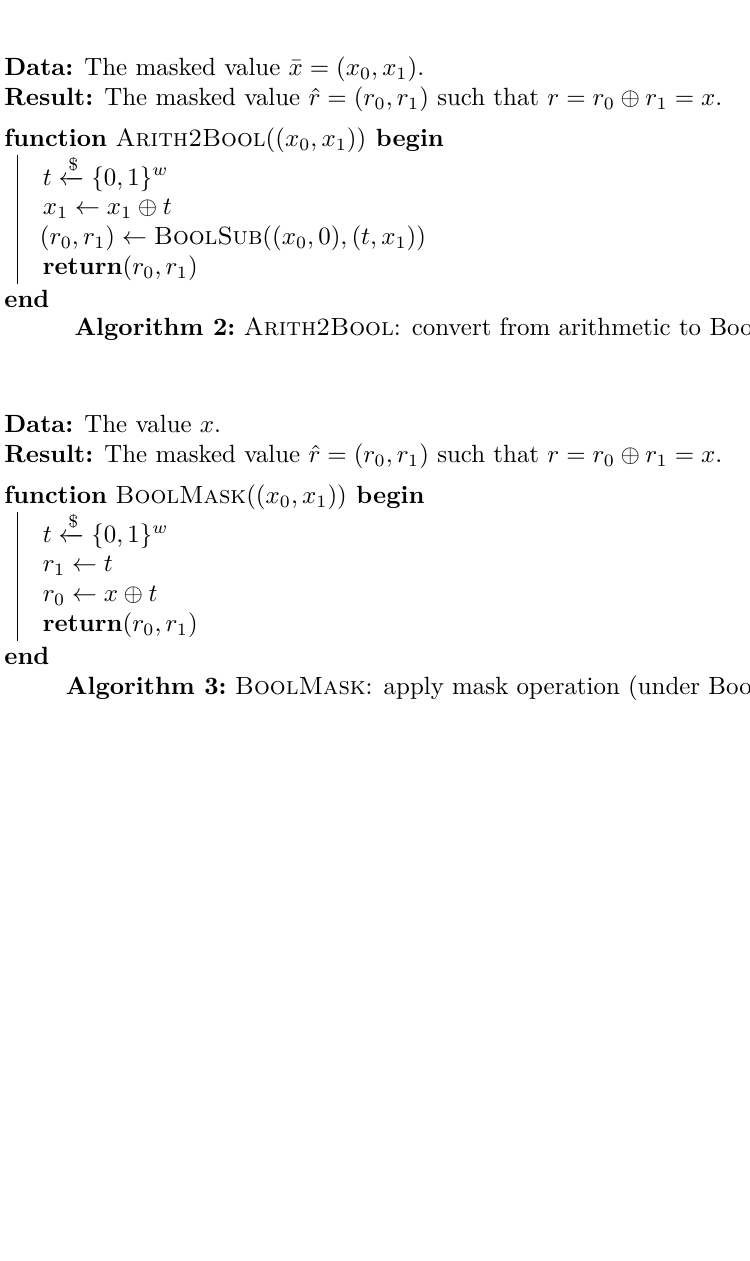
Algorithm 1: Bool2Arith : convert from Boolean to arithmetic masking.